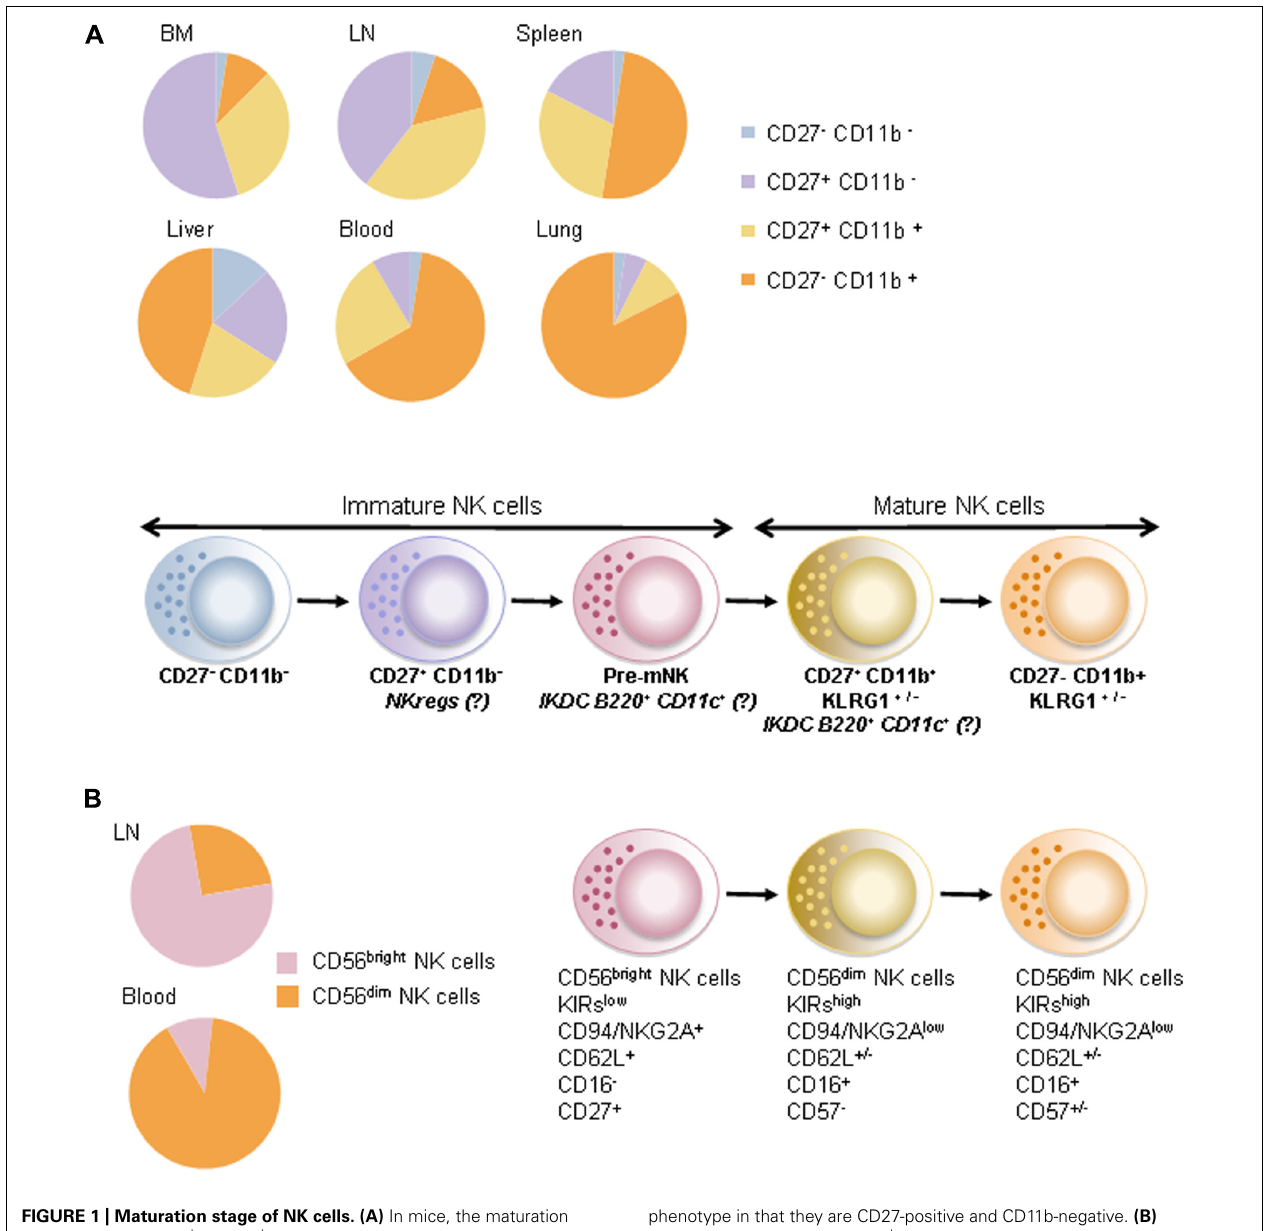
FIGURE 1 | Maturation stage of NK cells. (A) In mice, the maturation stage of CD3 − NK1.1 + NKp46 + NK cells is defined using both CD27 and CD11b molecule expressions. Upper panel shows relative proportions of NK cells at steady state in bone marrow (BM), lymph nodes (LN), spleen, liver, blood, and lungs. Lower panel shows the differentiation of NK cells based on the expression of CD27 and CD11b. IKDCs expressing B220 and CD11c molecules would be part of a premature NK cell fraction (pre-mNK) and of a CD27-positive fraction of mature NK cells also expressing the mannose receptor (CD206). NKreg cells have an